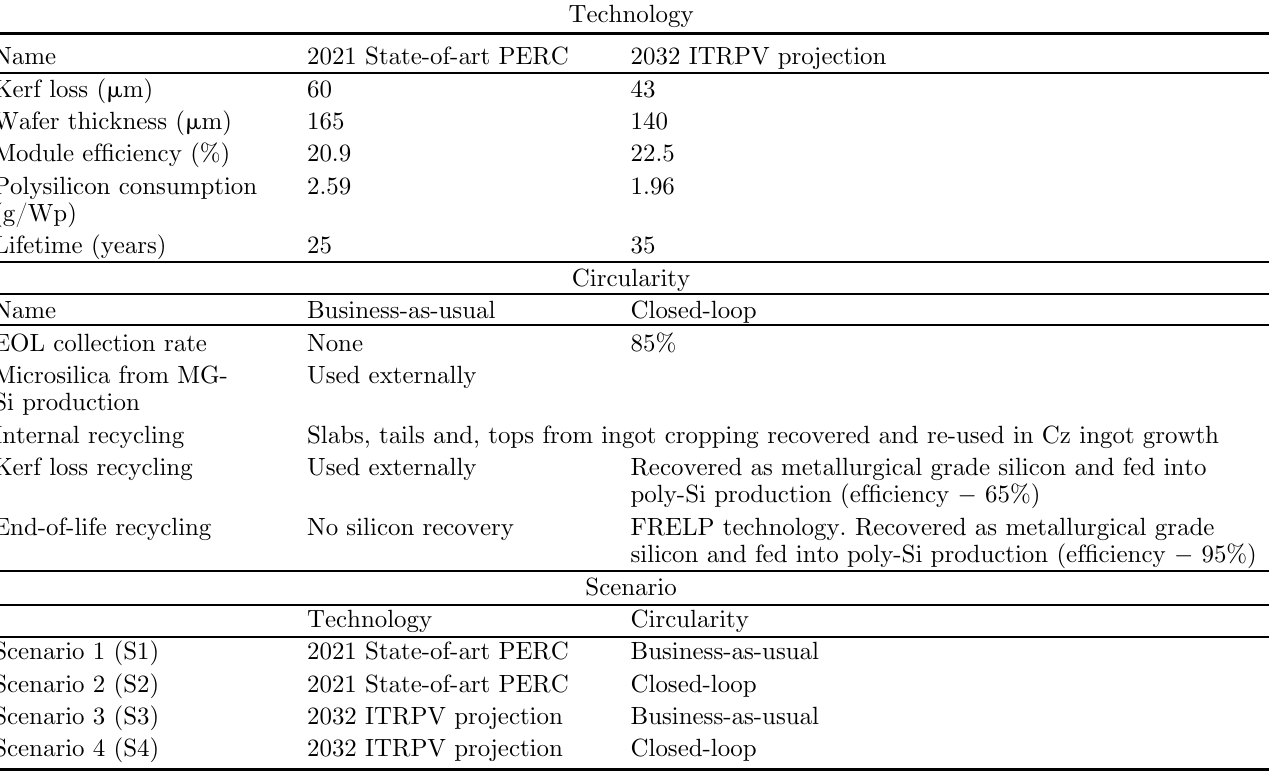
Table 2. Four scenarios applied in the study. Based on the combination of 2 technological pathways and 2 circularity